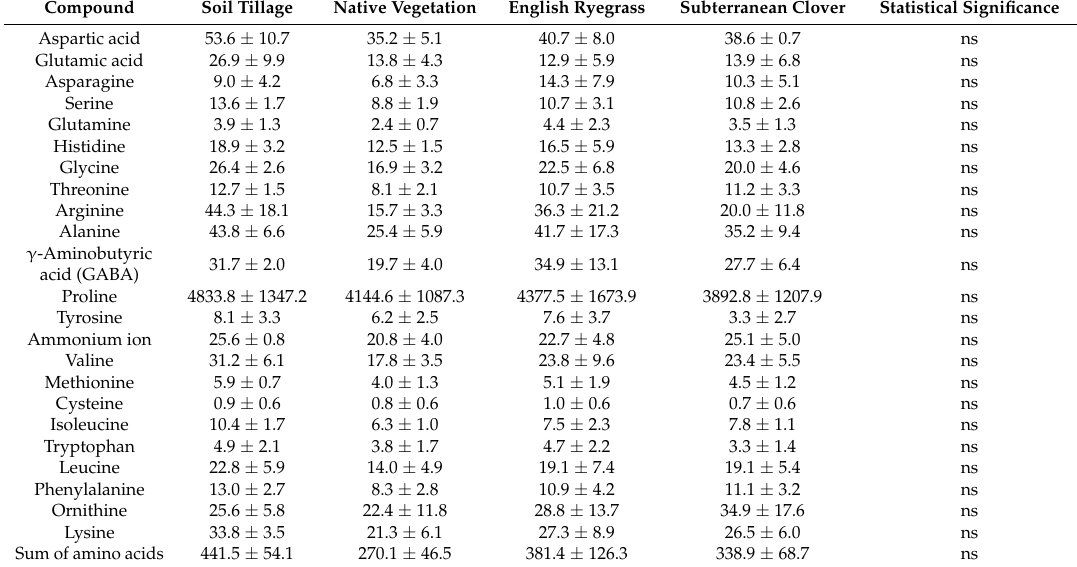
Table 4. Soil management effects on the amino acid concentrations (mean ± standard error, mg L −1 ) of wines from Mencía averaged for three seasons (2012–2014). Compound Soil Tillage Native Vegetation English Ryegrass Subterranean Clover Statistical Significance Aspartic